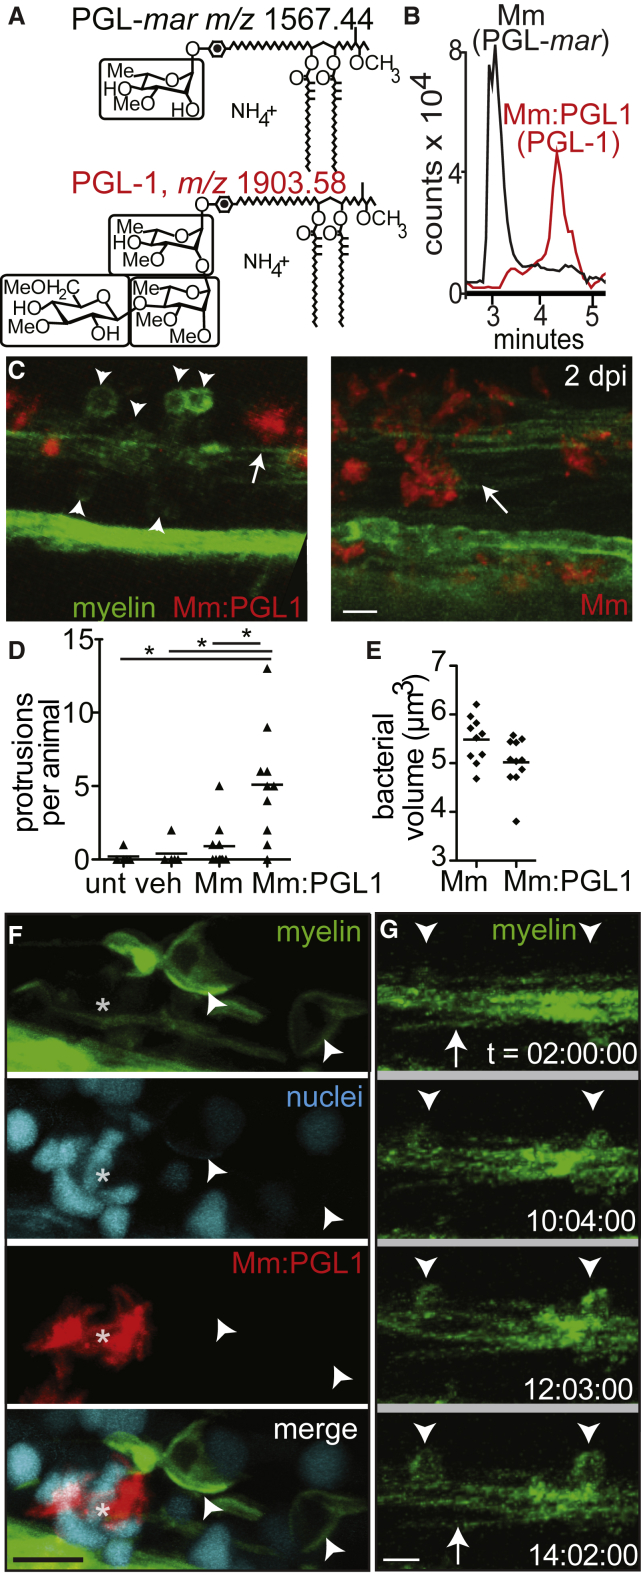
Phenolic Glycolipid 1 Triggers Myelin Dissociation(A) Normal phase high-performance liquid chromatography mass spectrometry measured at the known mass-to-charge ratios (m/z) for triglycosylated and monoglycosylated forms of PGL, leading to the separate detection of PGL-mar (m/z 1,567.44, upper structure) and PGL-1 (m/z 1,903.58, lower structure) in total lipid extracts of the indicated strains (B).(B) Chromatograms of the ions depicted in (A), showing the increased retention time of PGL-1 from M. marinum:PGL-1 (Mm:PGL1) compared to that of PGL-mar from WT M. marinum.(C) Representative confocal images, like in Figure 2C, of 2 dpi (4 dpf) larvae infected with ∼200 CFU M. marinum or M. marinum:PGL-1; myelin protrusions are quantified in (D). Scale bar, 10 μm.(D) Mean number of myelin protrusions per animal in uninjected larvae (unt) or after injection with PBS vehicle (veh), M. marinum, or M. marinum:PGL-1 (∼200 CFU each; ∗p < 0.05, one-way ANOVA with Bonferroni’s post-test).(E) Mean bacterial burden at the injection site of larvae from (D).(F) Representative confocal image of a 6 dpf larva with fluorescently labeled nuclei, 4 dpi with M. marinum:PGL-1 (∼100 CFU). Asterisk indicates an aggregate of infected cells. Scale bar, 10 μm.(G) Stills from time-lapse imaging of an mbp larva injected with M. marinum:PGL-1, showing myelin protrusions forming from apparently intact myelin. Arrow, intact myelin sheath; arrowheads, myelin protrusions. Relative time code. Scale bar, 10 μm.See also Figures S2 and S3 and Movie S2.